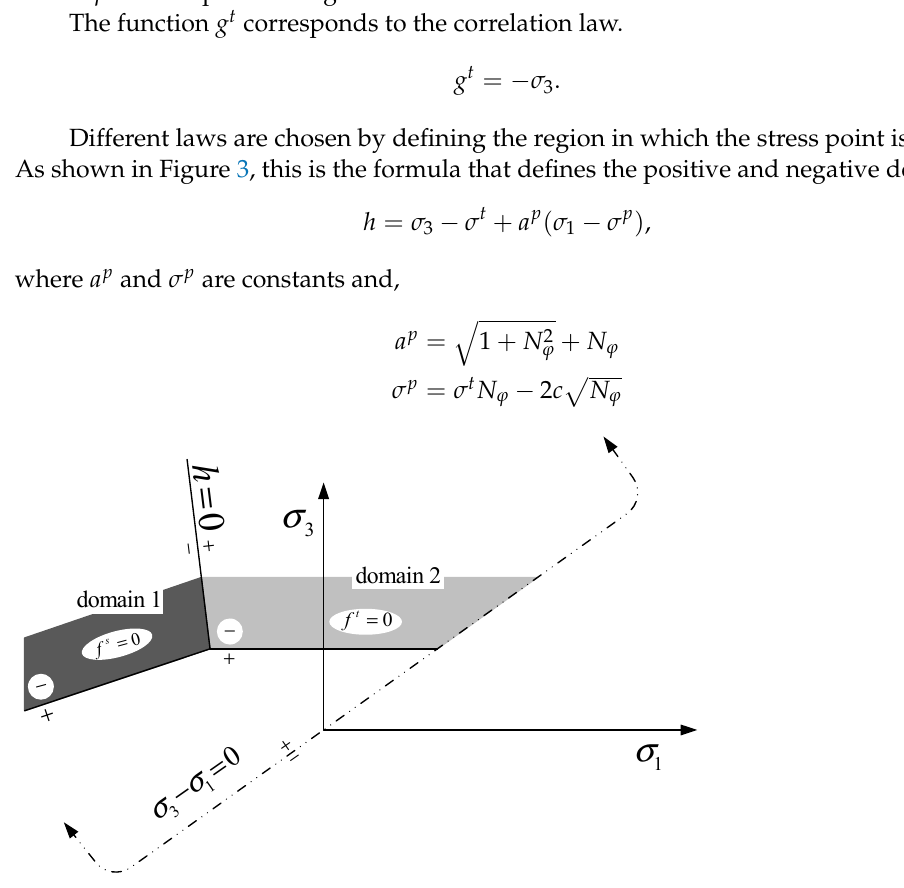
Figure 3. Definition domain of the laws of the Mohr–Coulomb model.